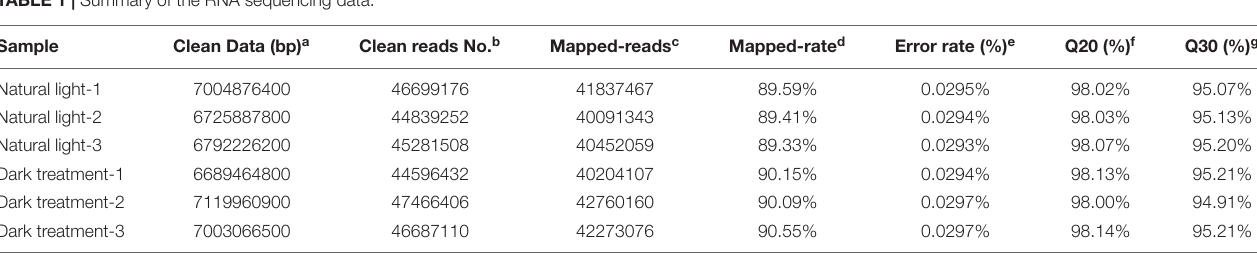
FIGURE 3 | Serum biochemical indexes in Litopenaeus vannamei . *indicated significantly difference among two groups ( P < 0.05). TABLE 1 | Summary of the RNA sequencing